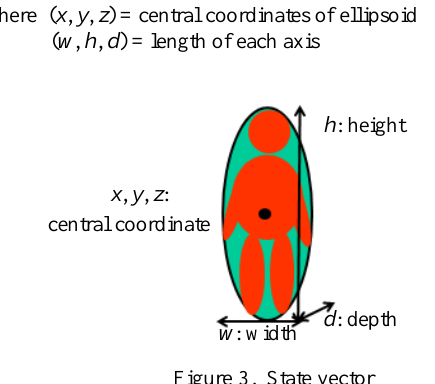
Figure 3. State vector